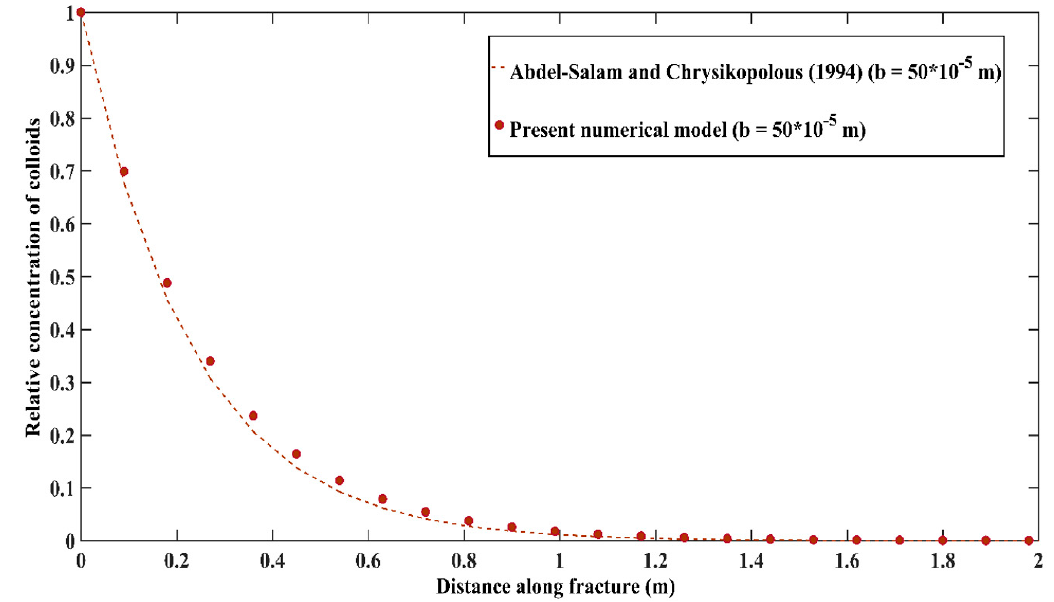
Figure 3. Verification of the present numerical model.